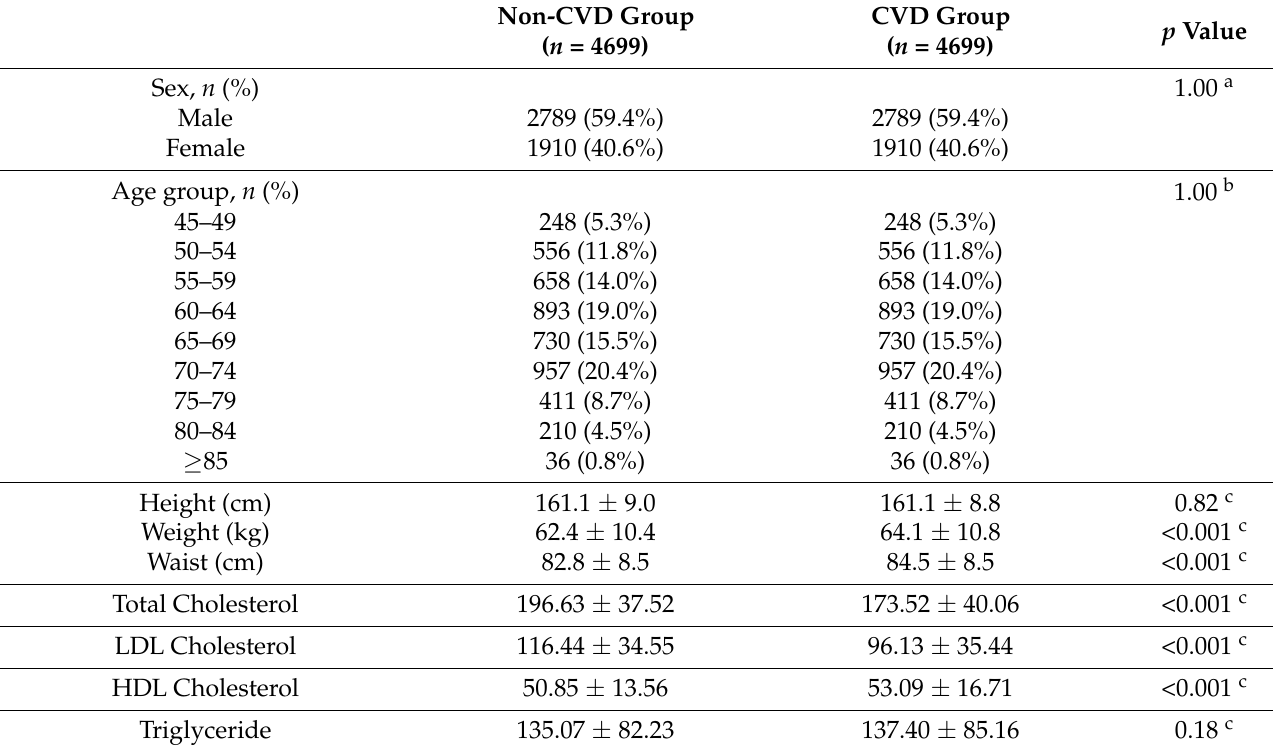
Table 1. Baseline characteristics and major contributing factors in the non-CVD and CVD